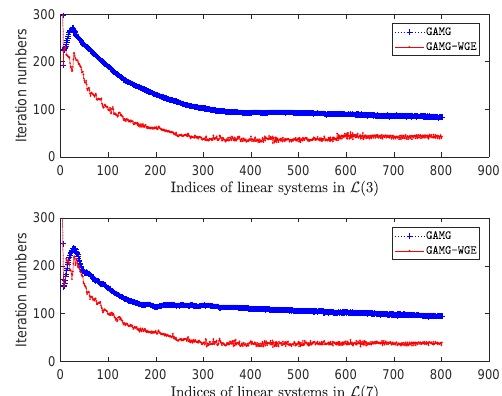
Figure 17. The iteration numbers of the linear equations in 3D blended-wing-body